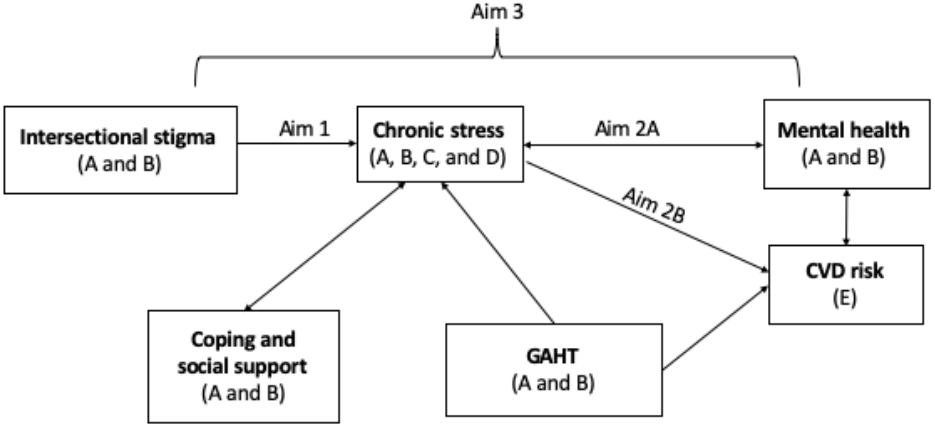
Figure 1. Hypothesized pathways linking stigma, stress, mental health, and cardiovascular disease outcomes among transgender women living with HIV to be measured using (A) survey, (B) qualitative interviews, (C) salivary cortisol, (D) allostatic load index, and (E) clinical measures. GAHT: gender-affirming hormone therapy; CVD: cardiovascular